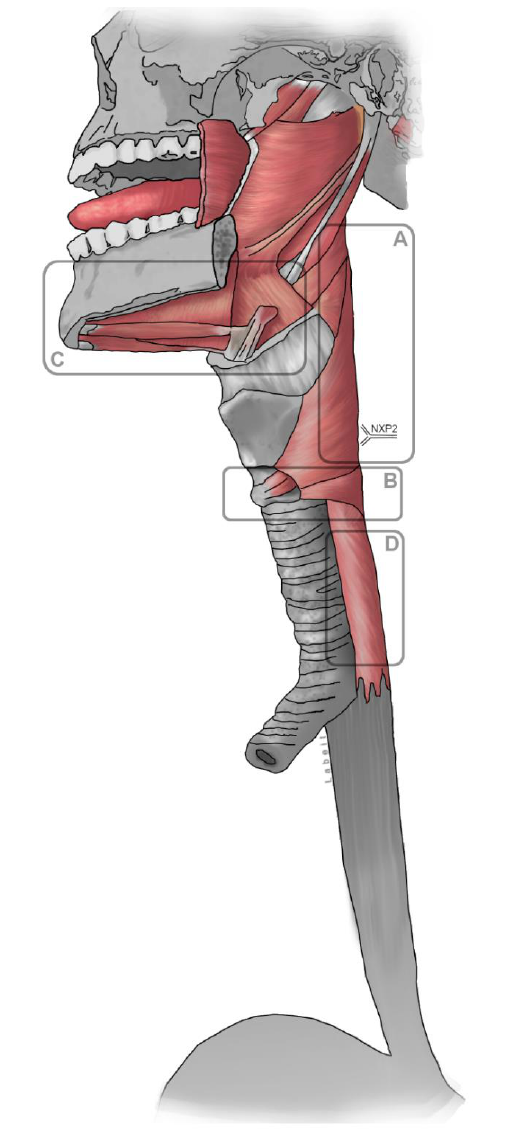
Figure 2. Skeletal swallowing muscles and the associated dysphagia mechanisms: A: Reduced pharyngeal contractility; B: Cricopharyngeal dysfunction; C: Reduced laryngeal elevation; D: Esophageal hypomotility.